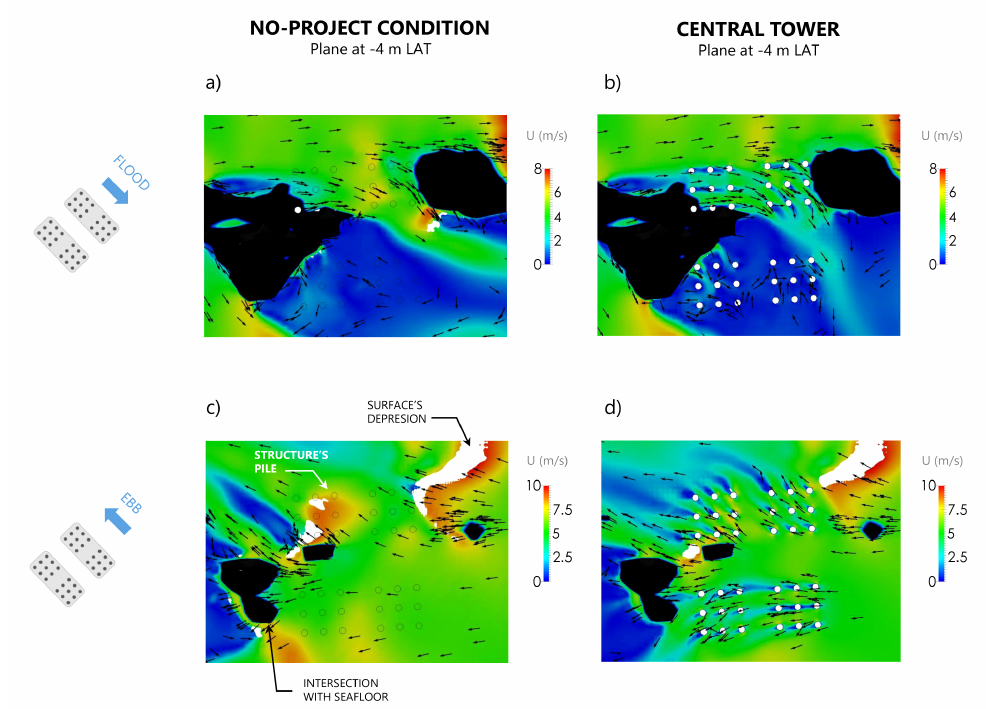
Figure 11. Velocity fields at − 4 m LAT in the Central Tower site for ( a ) the flood-tide scenario in the no-project condition and ( b ), with the future assemble of 36 piles. Similar results for ( c ) the ebb-tide scenario in the no-project condition and ( d ) with the piles’ structure. Arrows show the local flow direction, black circles the location of each pile, black regions represent seafloor located above − 4 m LAT and white regions areas where the water level is below − 4 m LAT. Figures adapted from